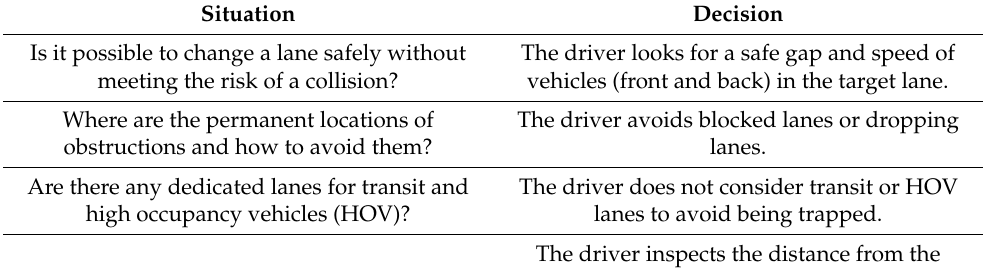
Table 4. Set of rules for Gipps lane-change model